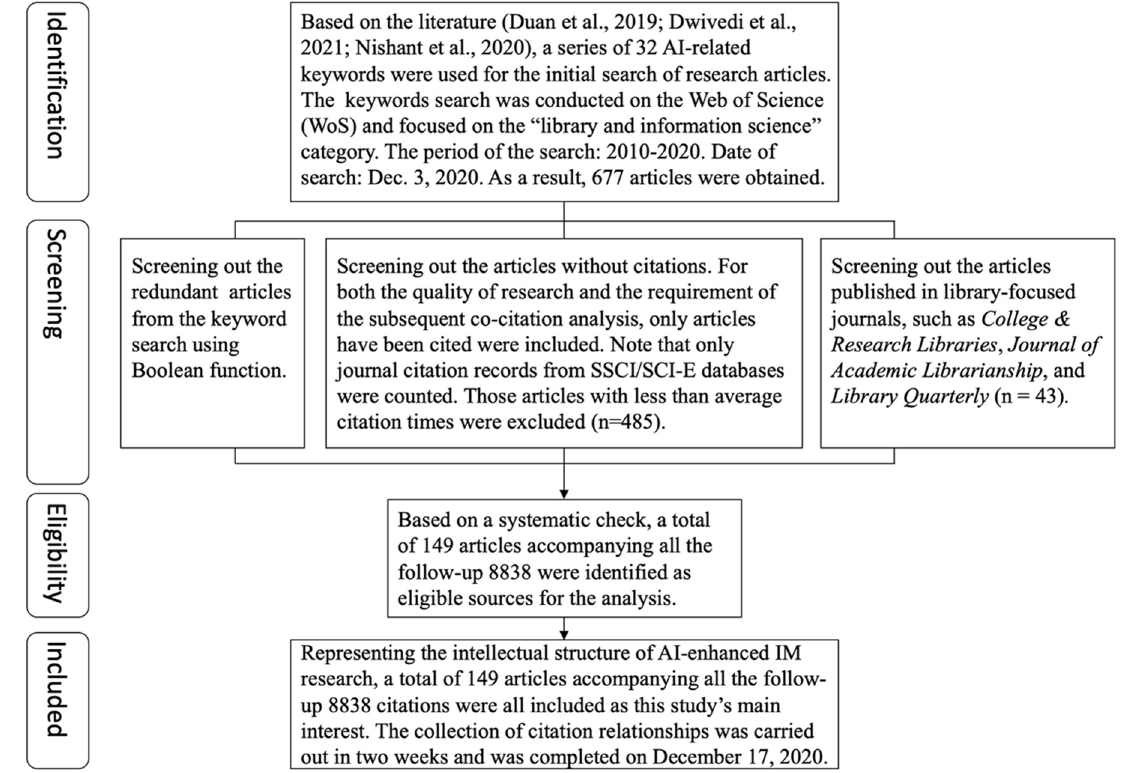
Fig 1. PRISMA diagram for inclusion of research